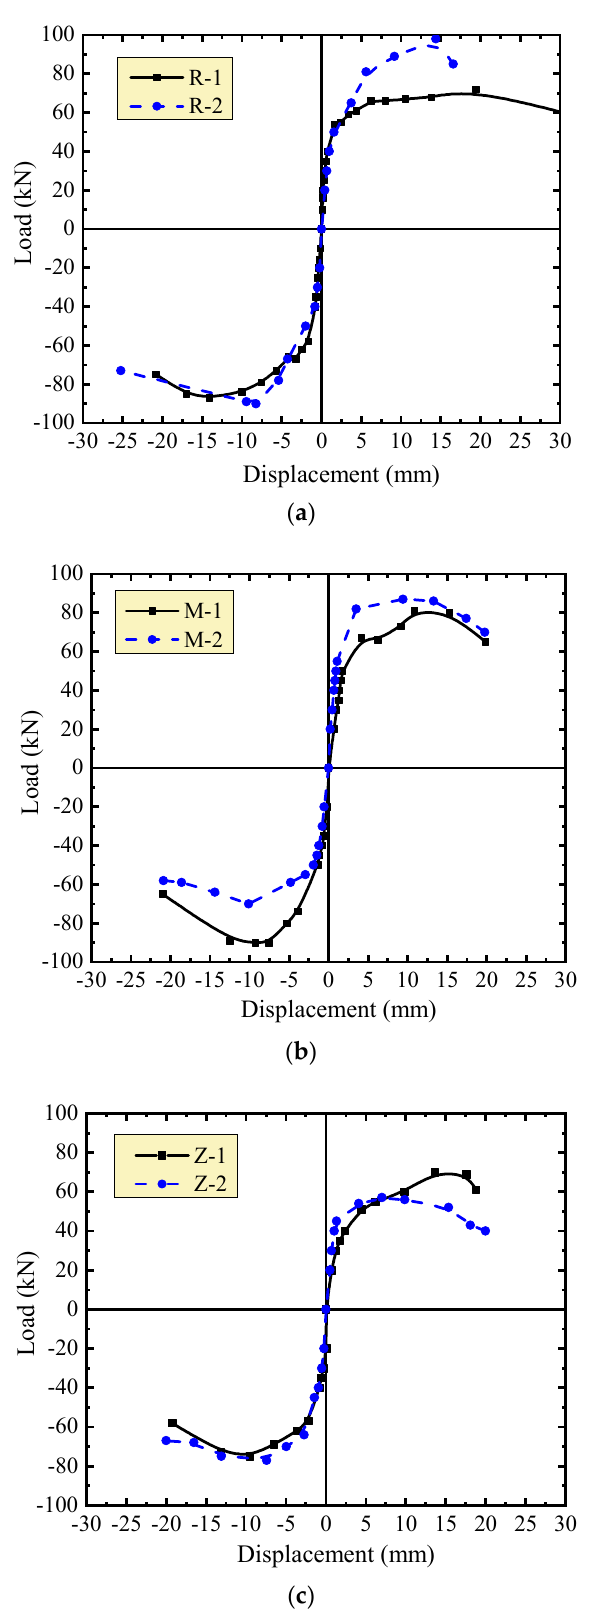
Figure 6. Comparison of envelop curves of the same wall under di ff erent vertical loads: ( a ) walls with insulation mortar joints; ( b ) walls with thin-layer mortar joints; ( c ) walls with vertical mineral wool